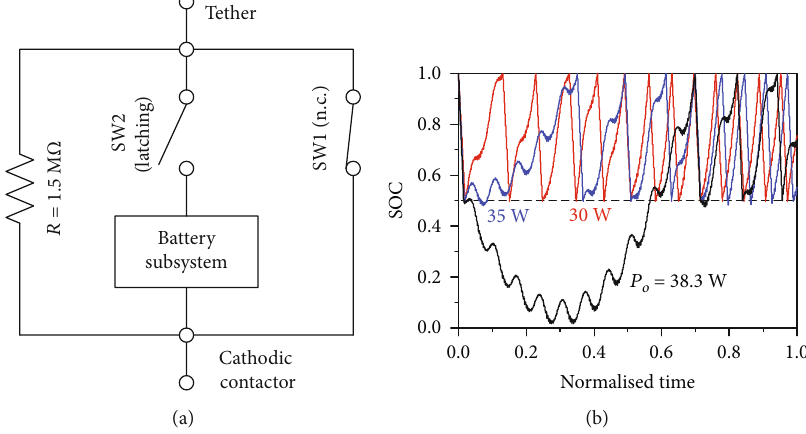
Figure 10: Strategy employed in ProSEDS: (a) simpli fi ed circuit; (b) SOC v. time.